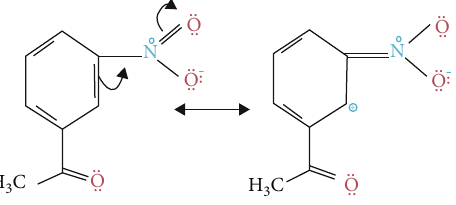
H 3 C Figure 9: Resonance structures of